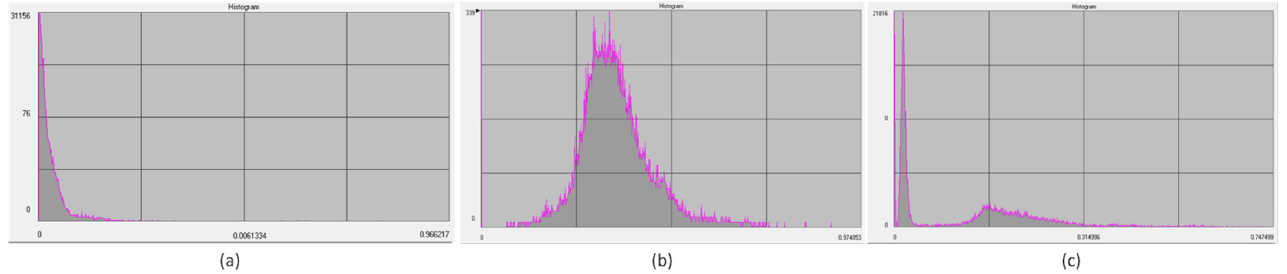
Figure 6. Bad bands histograms. Alba Fucens: ( a ) VNIR cube, band 2; and ( b ) SWIR cube, band 27; Sinuessa: ( c ) VNIR cube, band 61.